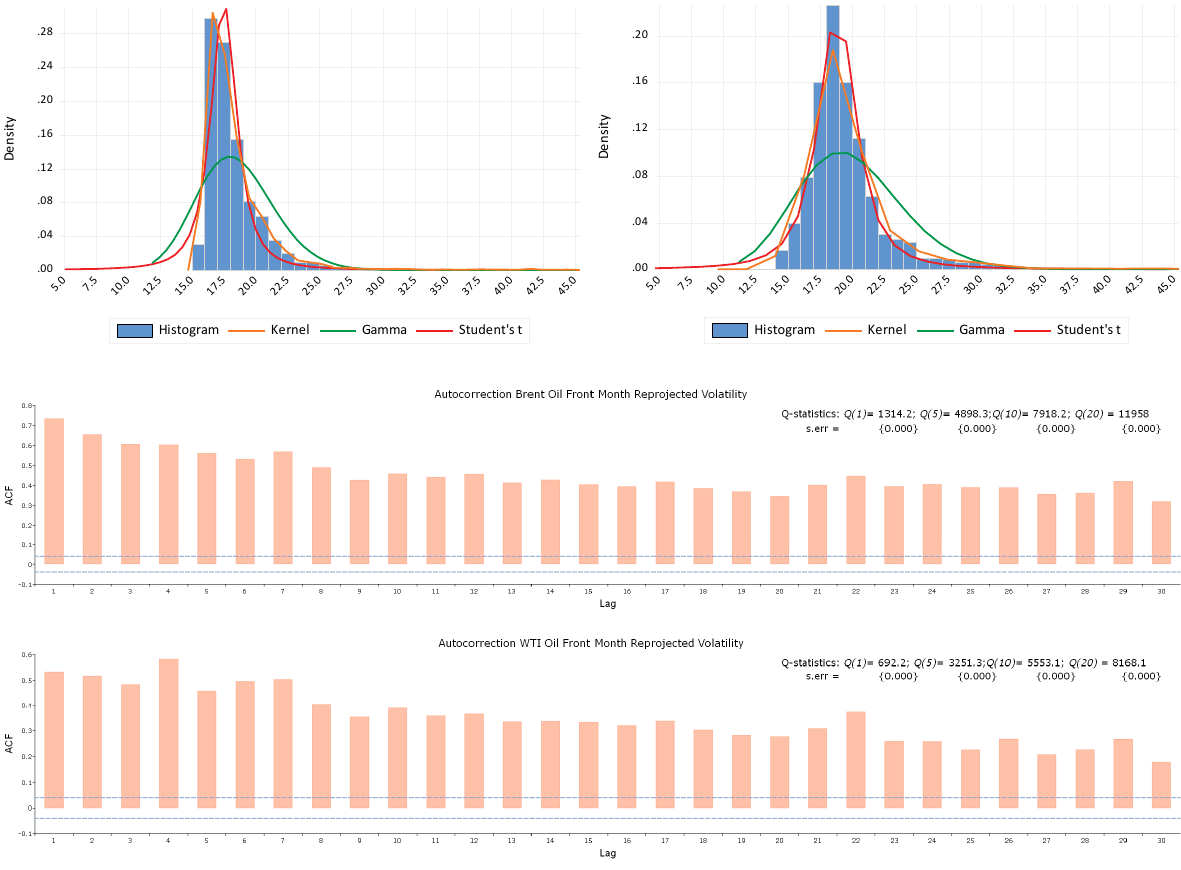
Figure 5. Daily Conditional Volatility from Observables and Kalman Filtered Volatility.